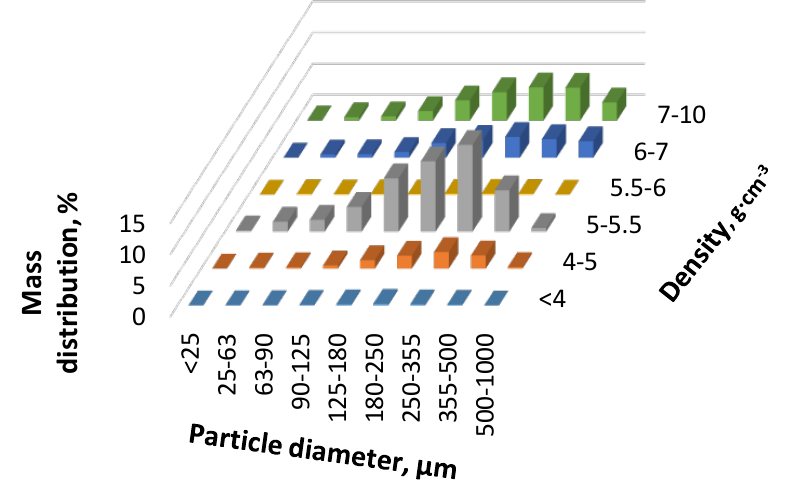
Figure 9. Mass distribution of particles in size and density categories generated using Mathworks Matlab 2017b.